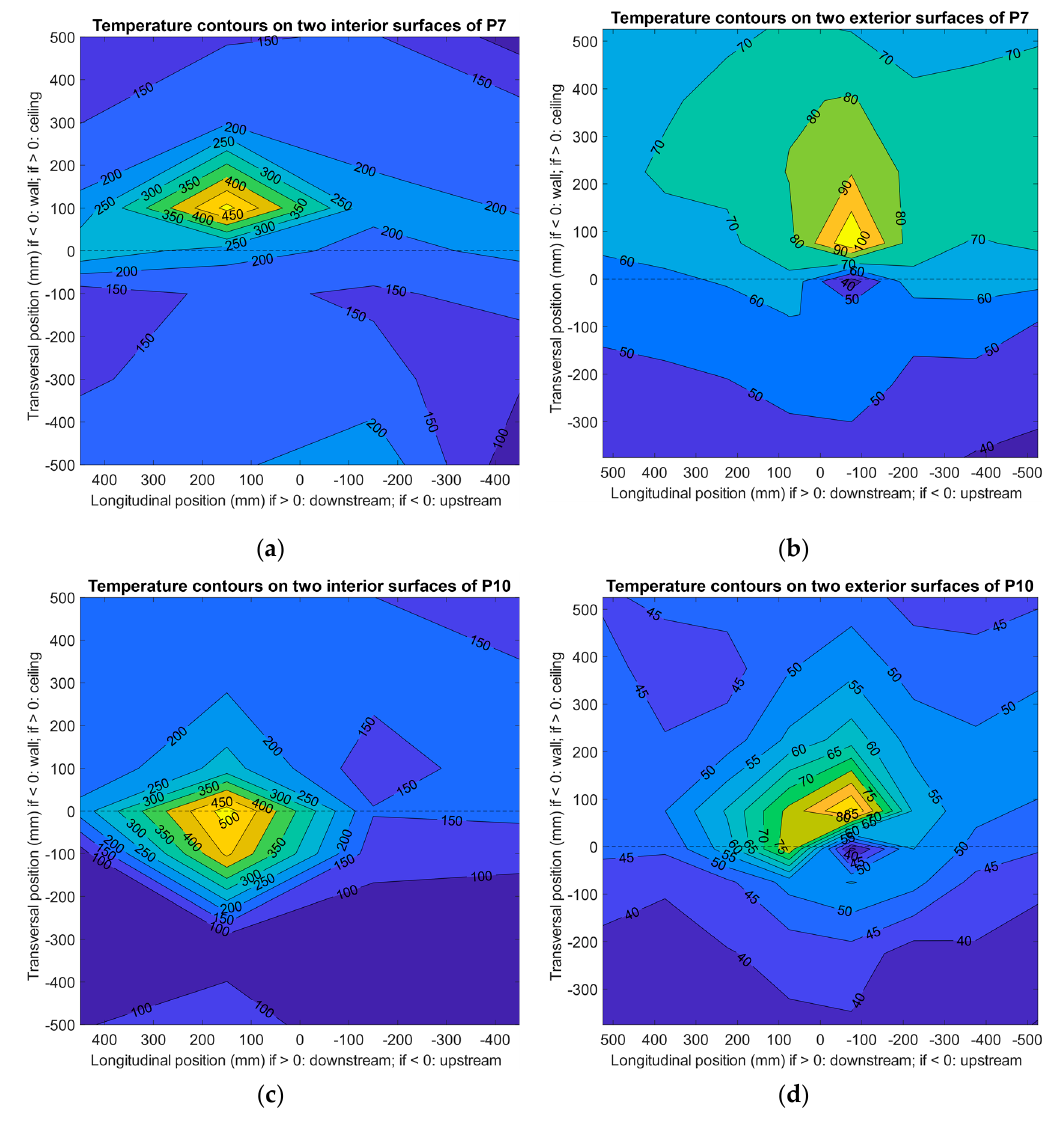
Figure 6. Effects of bare and covered angle irons on the thermal performance of Specimen 3 using a nozzle downstream and center, respectively, after impinging for 30 min (data were interpolated by grid measurements): ( a ) case P7, interior surfaces; ( b ) case P7, exterior surfaces; ( c ) case P10, interior surfaces; and ( d ) case P10, exterior surfaces.